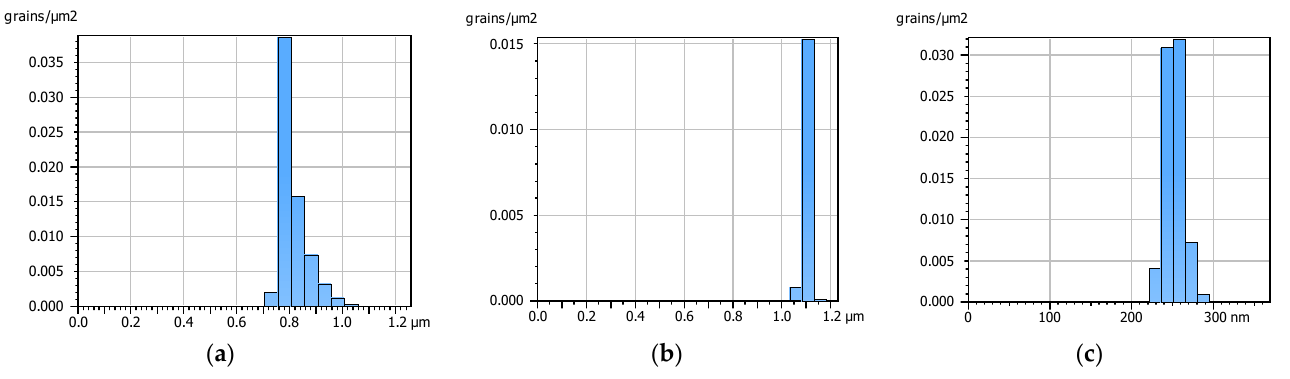
Figure 16. Peak count distribution graphs of surfaces: base no. 1 ( a ), modified no. 2 ( b ) and modified no. 3 ( c ).